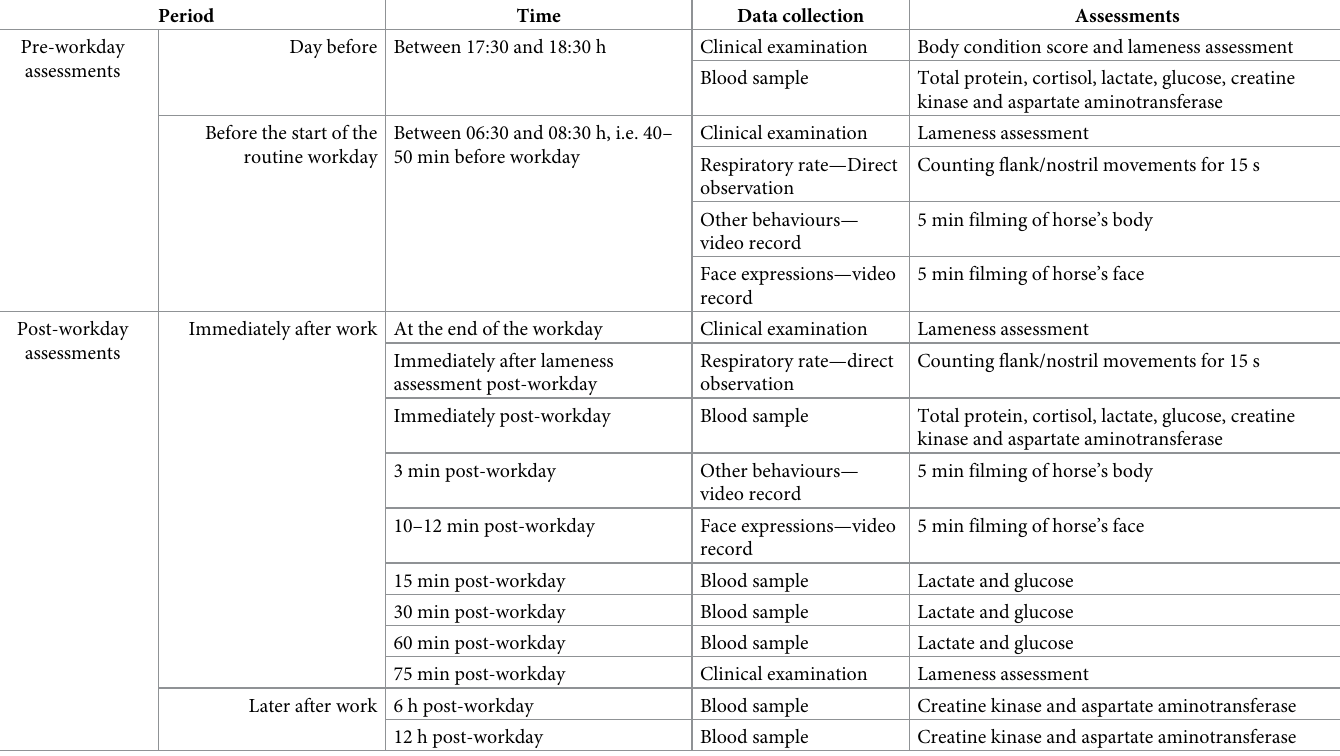
Table 1. Overview, in chronological order, of the data collection in ranch horses during the pre- and post-workday assessments.